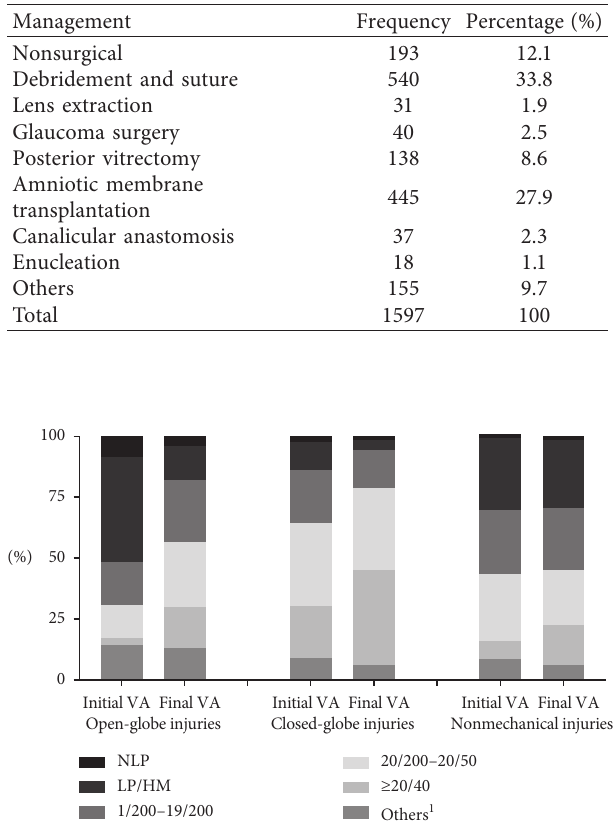
Figure 3: A comparison of the initial visual acuity and the final visual acuity in different types of injuries. 1 Others: patients cannot receive the visual acuity examination due to the young age or serious